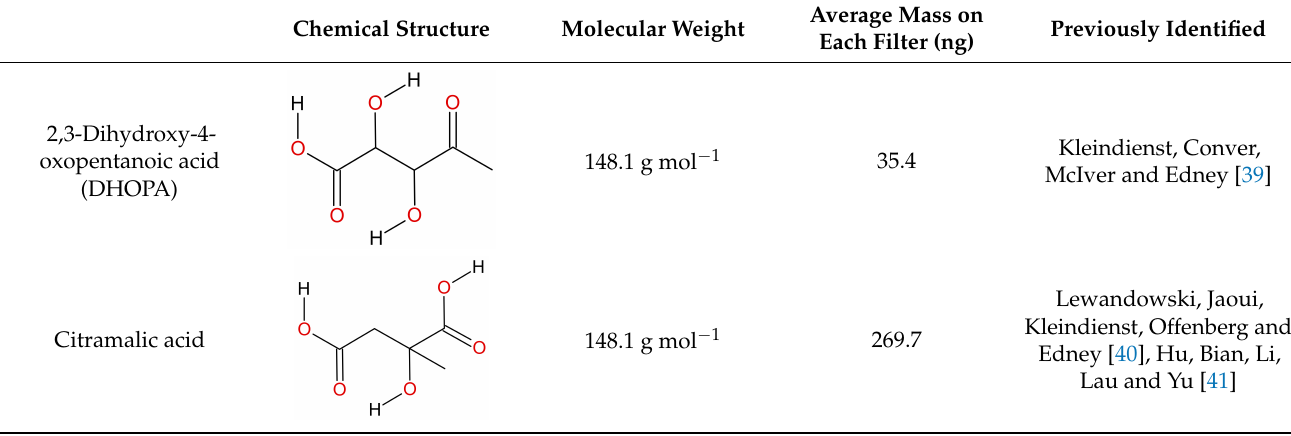
Table 2. List of particle phase products identified in SOA sample.